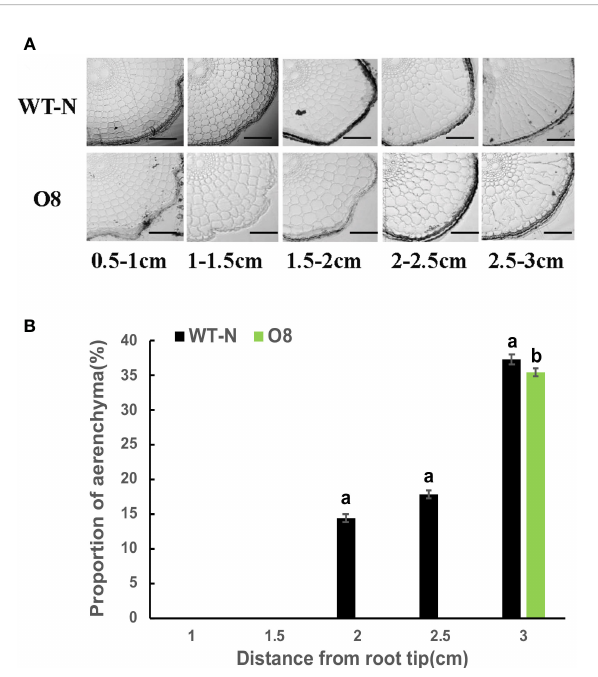
FIGURE 4 Describe aerenchyma formation in rice roots of WT and Ox2. Figure a-b show resin sections results of roots and aerenchyma formation (%) 0-0.5 cm, 0.5-1.0 cm, 1.0 – 1.5 cm, 1.5 – 2.0 cm and 2.0-2.5 cm from root apex in WT and Ox2 and signi fi cant difference between WT and Ox2 in each group are indicated by different letters: a= high value, b= lower value. Aerenchyma pics scale bar: 200um, Error bars: SE (n = 3) ( t -test, p< 0.05).